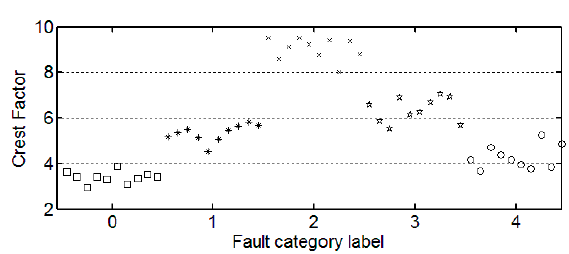
Figure 4. The trend of crest factor.